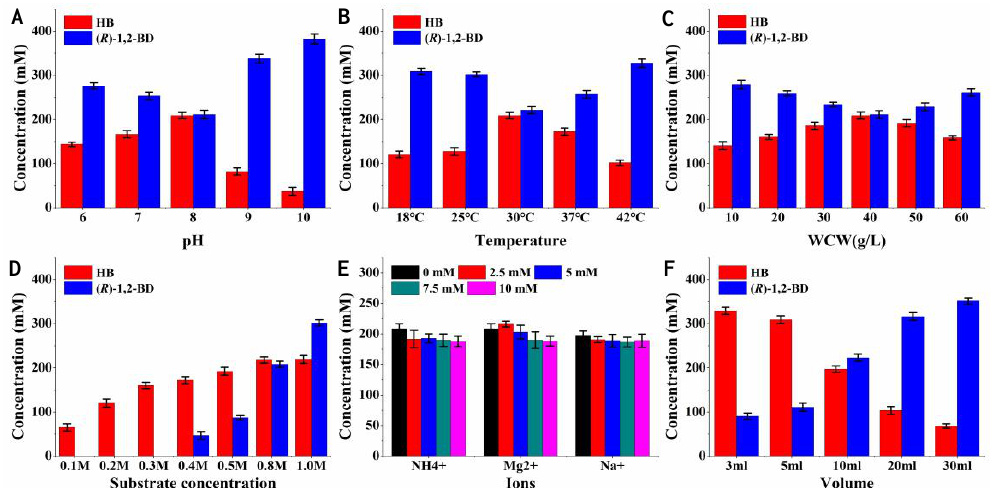
Figure 4 Effects of pH (A), temperature (B), wet cell weight (C), substrate concentration (D), ion (E), and reaction volume (F) on HB production from 1,2-BD mixture by whole cell biocatalyst of E. coli Figure 4. Effects of pH ( A ), temperature ( B ), wet cell weight ( C ), substrate concentration ( D ), ion ( E ), and reaction volume ( F ) on HB production from 1,2-BD mixture by whole cell biocatalyst of E. coli (pET- rrbdh - nox - vgb ). (pET- rrbdh - nox - vgb ).